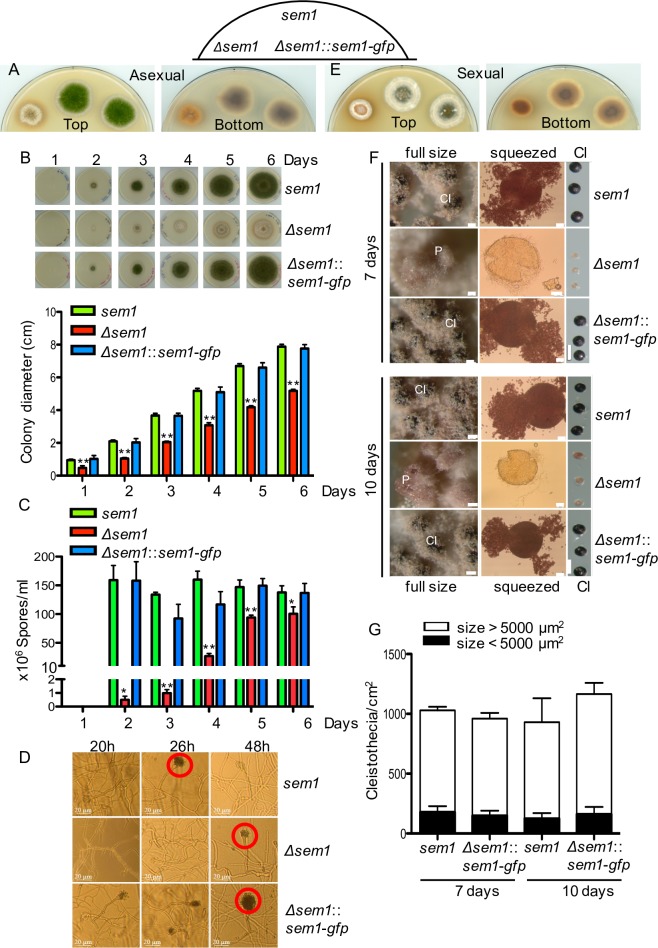
Sem1 is required for the maturation of cleistothecia in A. nidulans.(A) The Δsem1 strain is delayed in formation of green asexual spores on minimal media in light in comparison to A. nidulans wildtype strain (sem1) or the complementation strain (Δsem1::sem1-gfp) with a functional Sem1-GFP. (B)
Δsem1 grows slower compared to sem1 or complementation strains. Upper panel- the respective strains were point-inoculated with 10,000 spores and incubated in light for the indicated time points. Lower panel- the colony diameter was plotted. The wildtype grows 1.3±0.03 cm per day and Δsem1 grows 0.81±0.03 cm per day. Significance of differences was calculated with t-test compared to sem1, **p<0.01, n = 4. (C) Deletion of sem1 impairs asexual spore formation. Spores were visible in all strains only after 2 days of asexual growth. Wildtype and complementation produced ≈ 150x106 spores/ml, this number remained similar over the time course. Increased conidia were measured in the deletion strain over time, with maxima of ≈ 94x106 spores/ml after 5 days of asexual growth (64% compared to wildtype). For the quantification of asexual spore, plates were inoculated with 10,000 spores and harvested at the indicated time points. The values shown are the average ± SD from 2 independent experiments. Significance of differences was calculated with t-test compared to sem1, *p<0.05, **p<0.01. (D)
Δsem1 mutant strain shows delayed formation of conidiophores (red circles). All asexual growth impairments were restored in the complementation strain. (E) Sem1 is required for maturation of sexual fruiting bodies (cleistothecia) in darkness. (F)
Δsem1 mutant strain is block in early sexual development and develop only Hülle cells and primordia (p) after 10 days of sexual growth. Wildtype and complementation strains produced pigmented cleistothecia (Cl) after 7 days. Cleistothecia were squeezed to check for the presence of ascospores. Scale bars: 50 μm for full size images, 20 μm for squeezed cleistothecia and 200 μm for the panel comparing the size of the sexual structures in the respective strains. (G) Similar numbers of cleistothecia per cm2 were observed in wildtype or complementation strains. The average size of the cleistothecia from Δsem1 was 5850±823 μm2. 15% of cleistothecia from wildtype and complementation had similar size and contained ascospores (Fig 1F, squeezed panel). Columns represent average number of cleistothecia ± SD per cm2, n = 2.